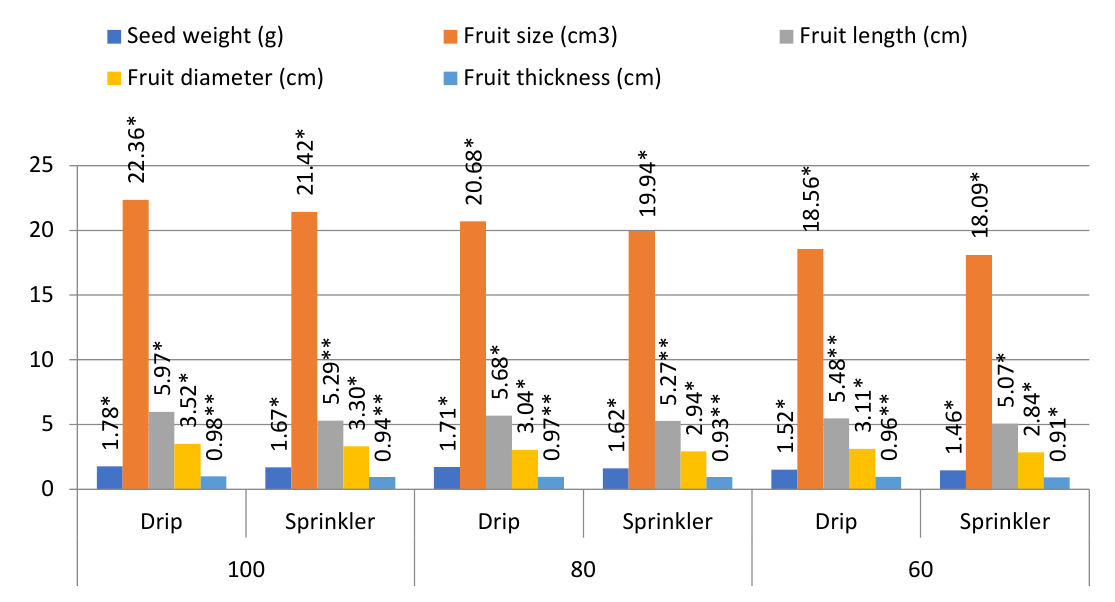
Figure 8. Effect of different irrigation and water treatments on seed weight, fruit size, fruit length, diameter and thickness of date palm. Significant differences *, Non-significant **, (ha):